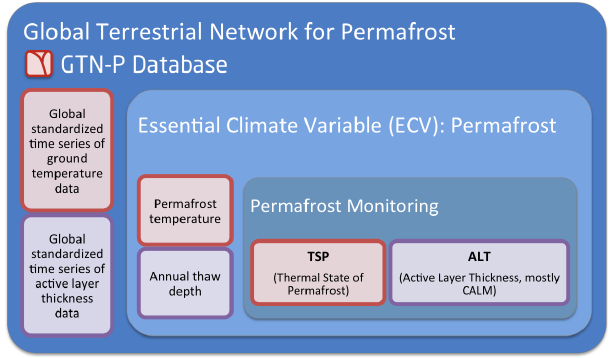
Figure 1. Framework within the Global Terrestrial Network for Permafrost defined by permafrost temperature and active layer thickness (ALT) data collected by the TSP and CALM programs,